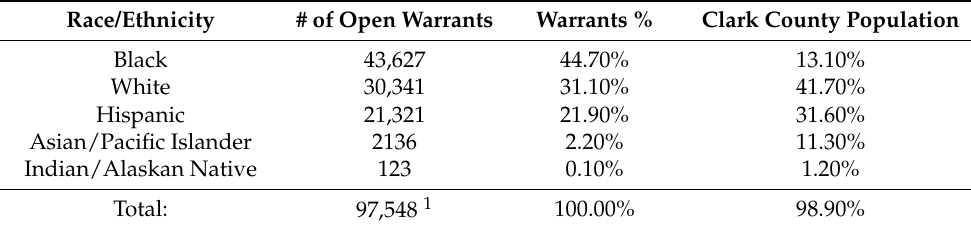
Table 5. Racial/Ethnic Distribution on Open